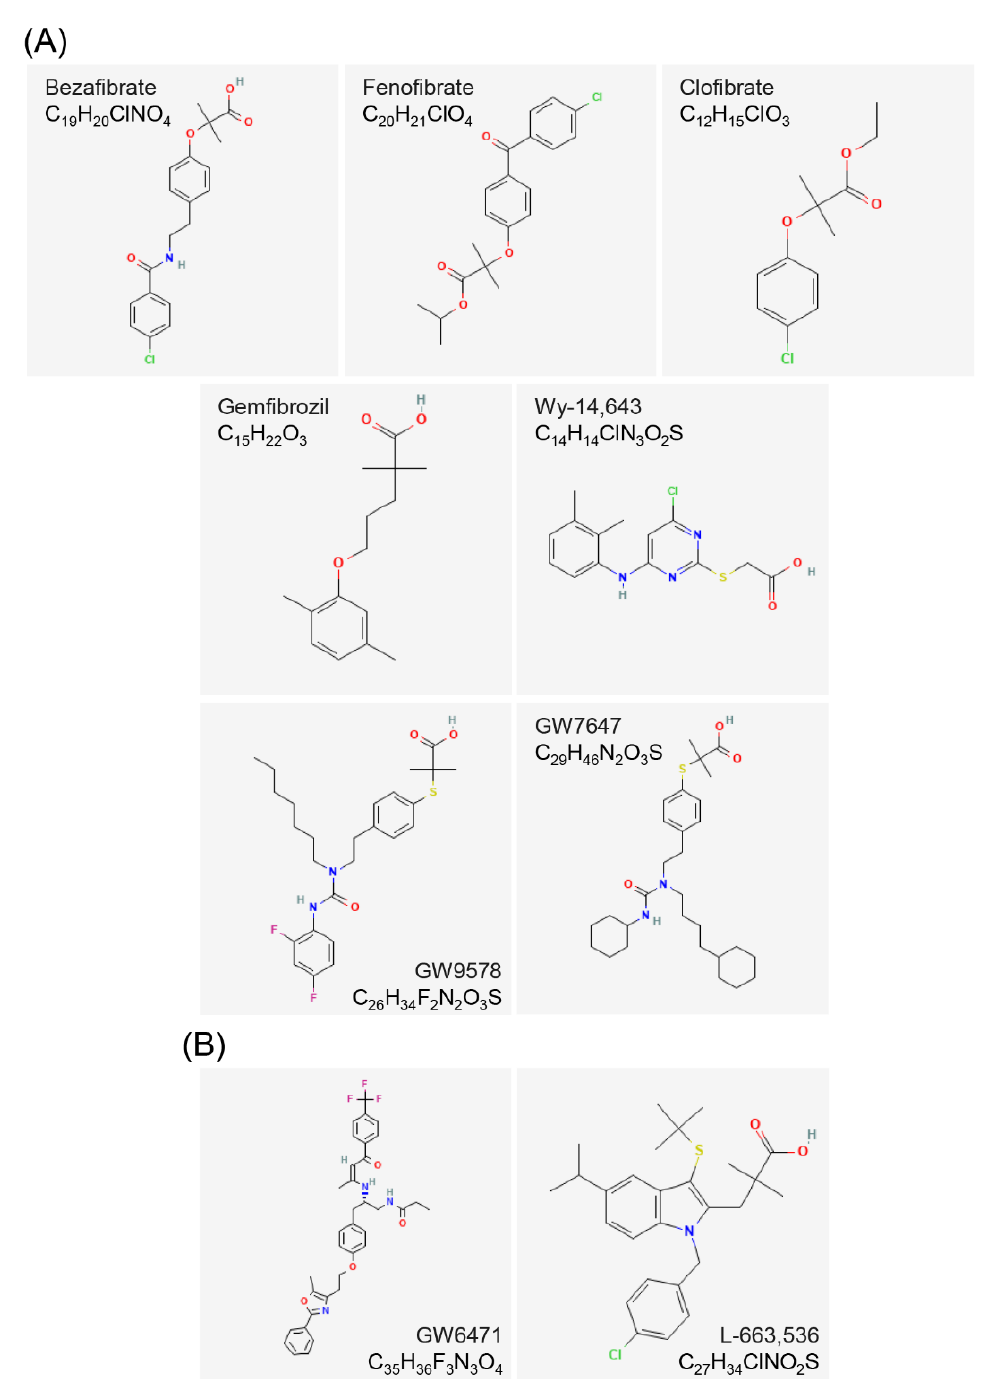
Figure 3. Agonist ( A ) and antagonist ( B ) secondary structures of PPAR α